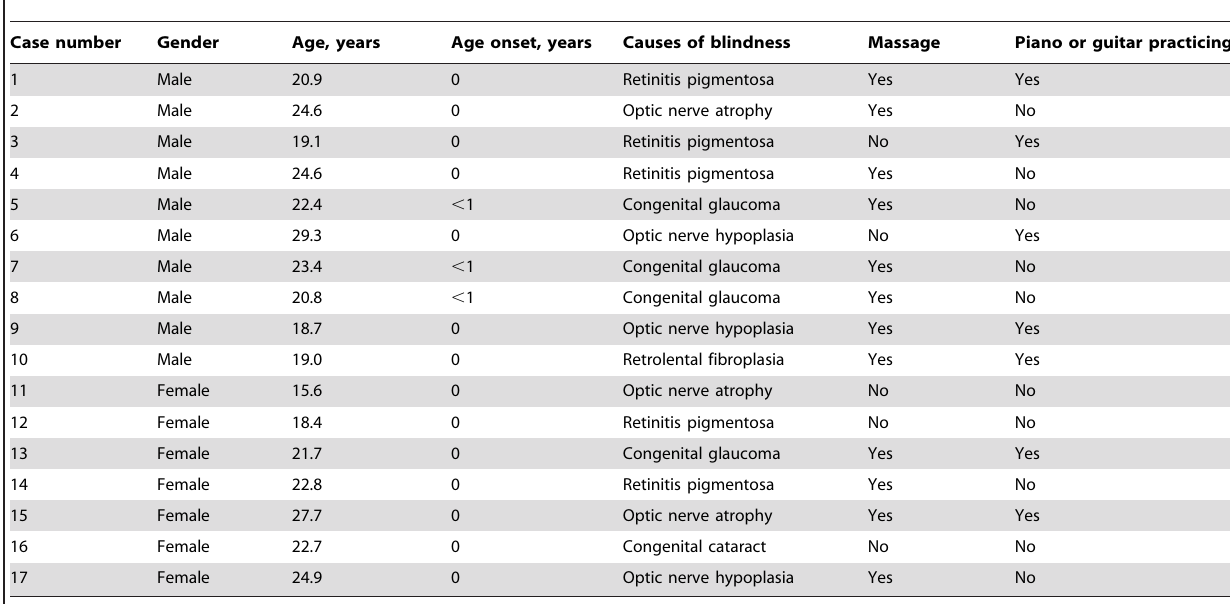
Table 1. Demographic data of the early blind